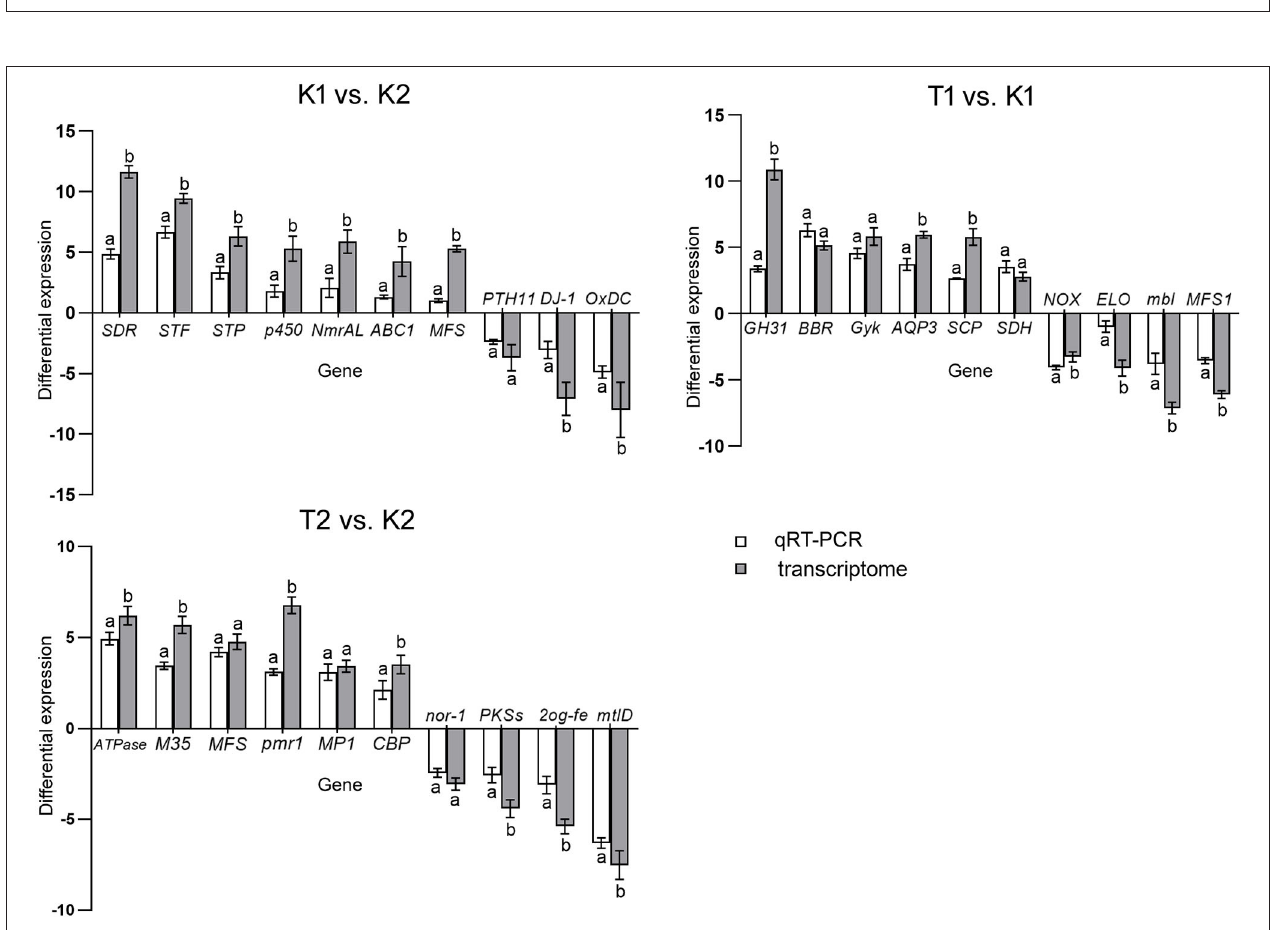
FIGURE 5 | Histogram of relative expression of DEGs by qRT-PCR and transcriptome analysis. All assays were repeated three times, the data were analyzed using one-way ANOVA and Duncan’s range test in SPSS 16.0. Different lowercase letters showed that there were significant differences in the expression level of the same gene between the qRT-PCR and transcriptome analysis ( p ≤ 0.01). White column represents the differential relative expression after normalization with GAPDH as the reference gene in the compared groups. Gray column represents the gene differential expression in the transcriptome differential analysis of the comparison groups.